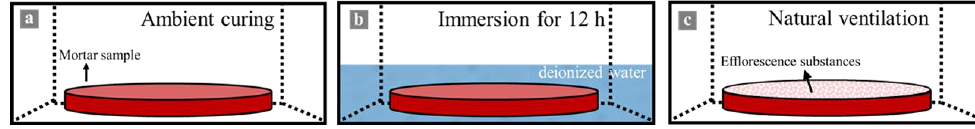
Figure 1. The schematic diagram of curing methods. (( a ). Primary efflorescence; ( b ). Accelerated efflorescence by immersion; ( c ). Secondary efflorescence).